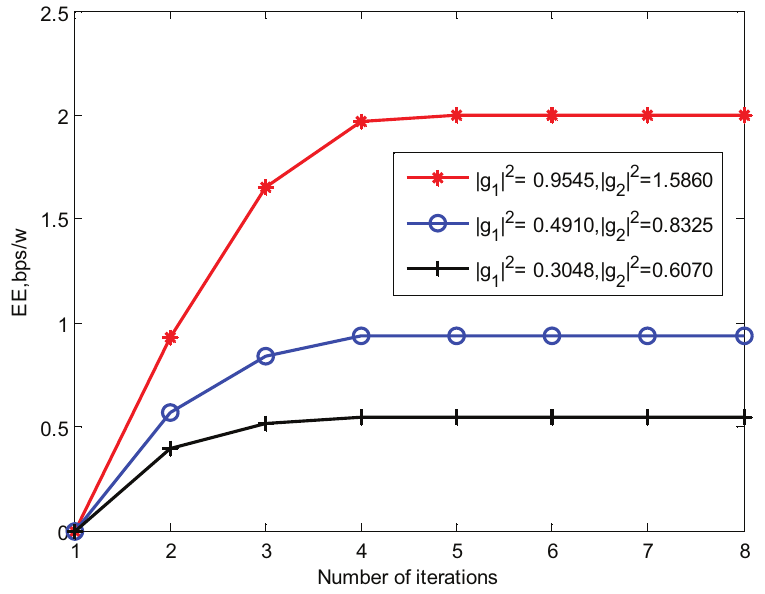
Figure 3. EE versus iteration numbers of Algorithm